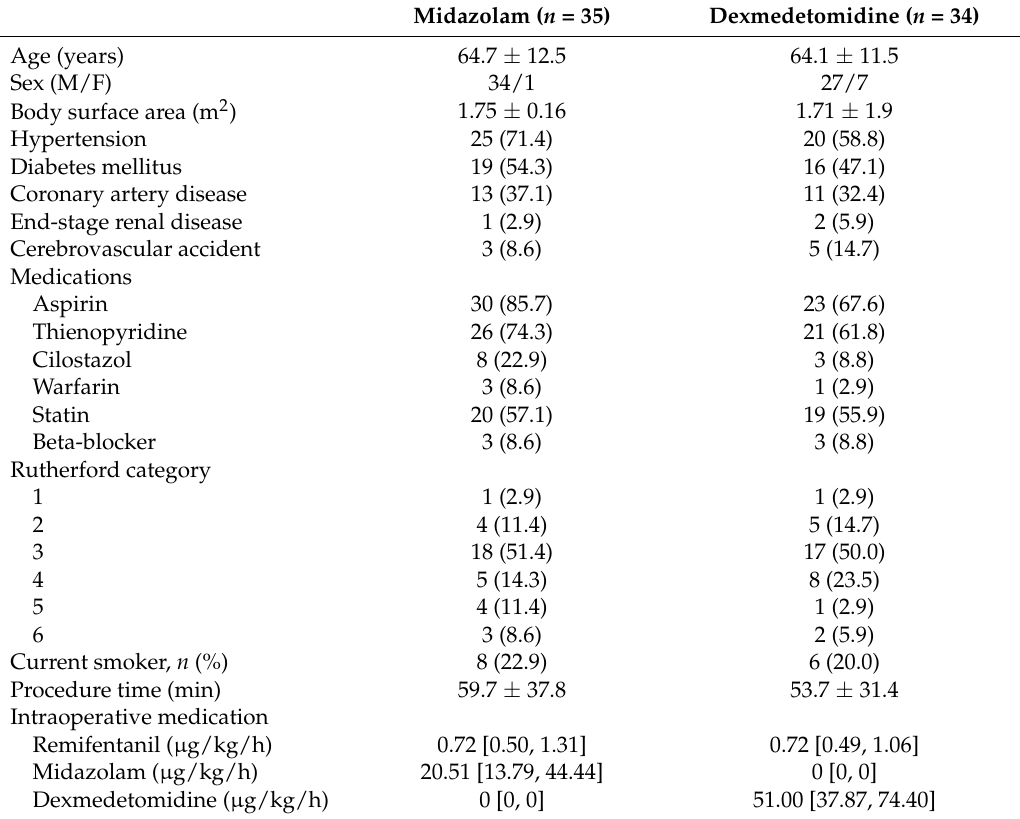
Table 1. Patients’ Characteristics and procedural data.